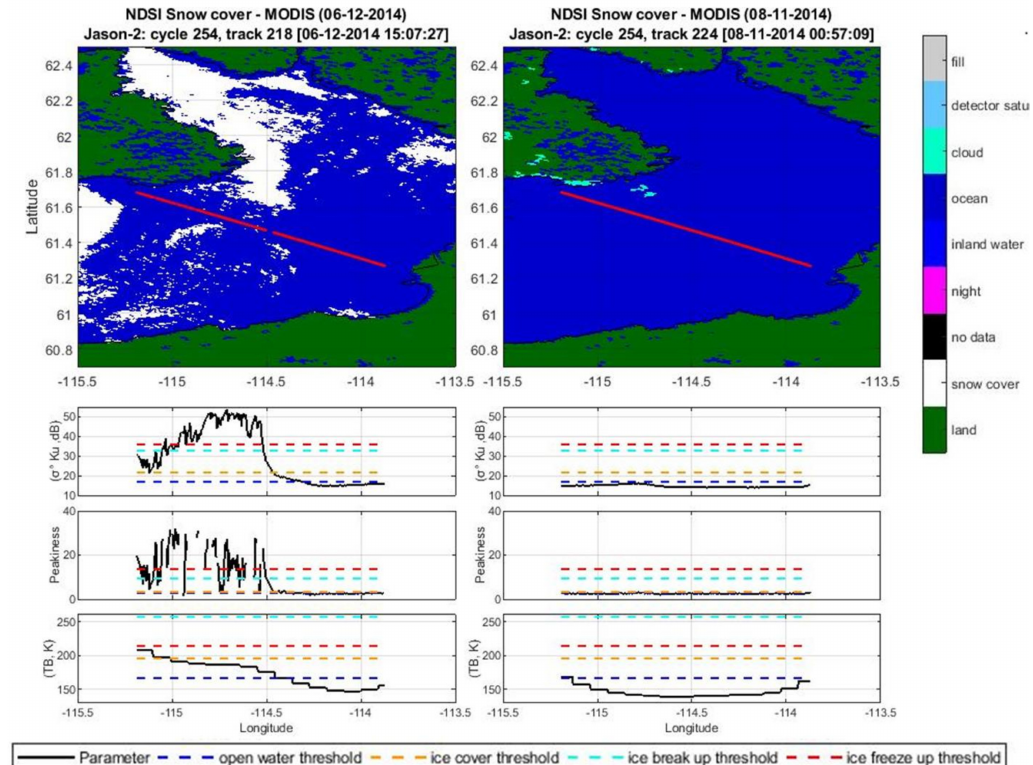
Figure 8. Examples of NDSI snow cover images over Great Slave Lake at di ff erent dates of the ice cycle: ice break-up (12 June 2014) and open water (11 August 2014), ground profiles of backscatter, peakiness and average brightness temperature that were observed on the same dates under the thresholds of discrimination between ice and